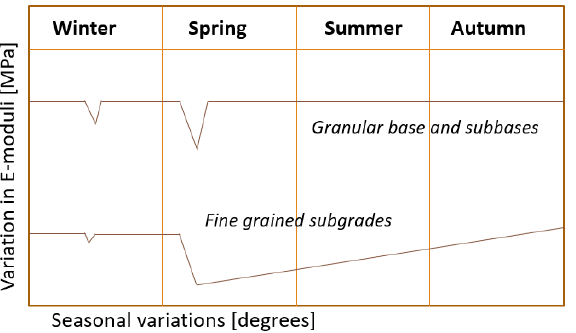
Figure 6. Seasonal variation and effect on granular base, subbases and fine grained subgrades. Inspiration from